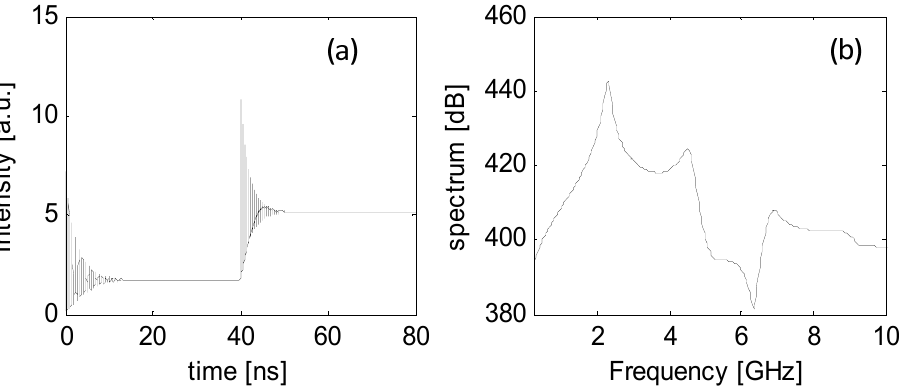
Figure 14. Transient response of a laser with EOF when the injection current has a step change from 1.1 J th to 1.3 J th at 40 ns ( a ) laser intensity ( b ) the corresponding spectrum.